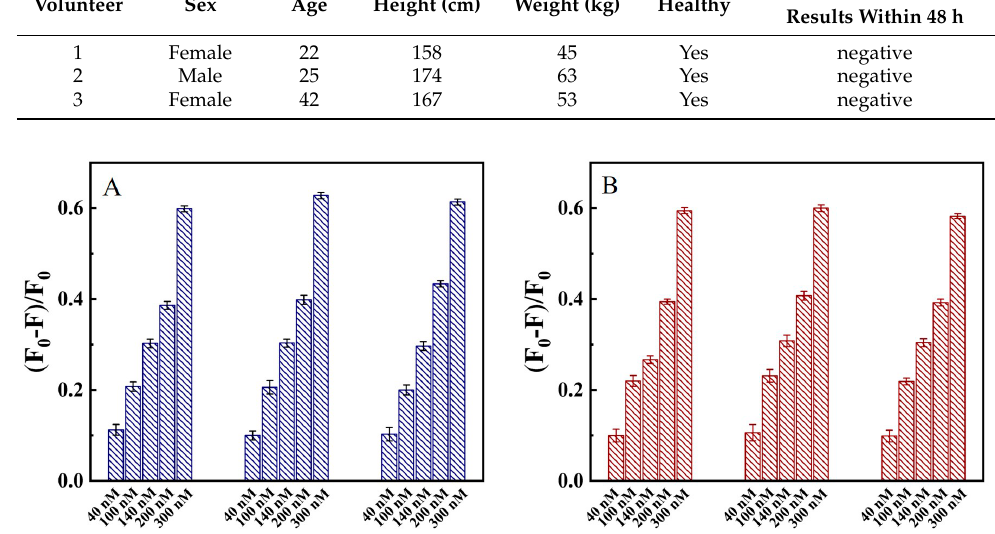
Figure 8. ( A ) (F 0 –F)/F 0 value at various concentrations of N protein spiked to the human serum sample. ( B ) (F 0 –F)/F 0 value at various concentrations of N protein spiked to the throat swabs sample. Table 1. Basic clinical characteristics of three volunteers.